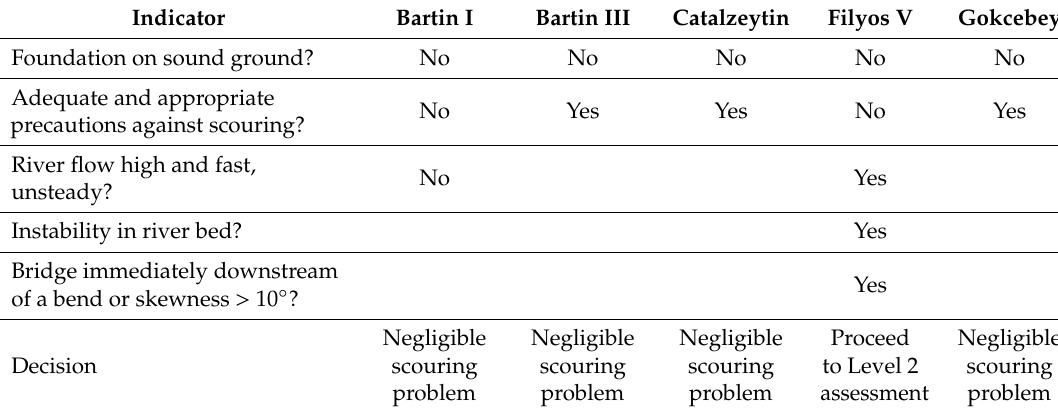
Table 17. Rapid scour assessment for river